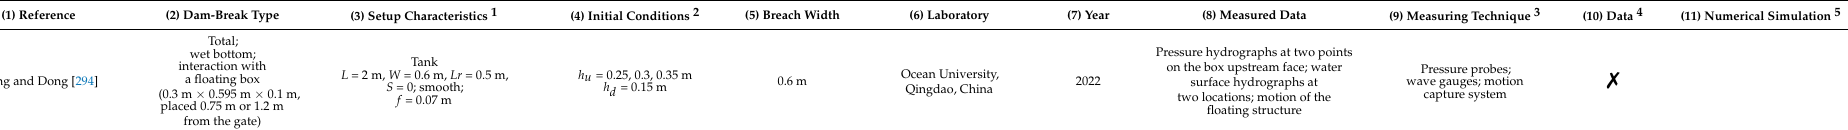
Table 1. Basic experimental investigations of fundamental dam-break wave physical